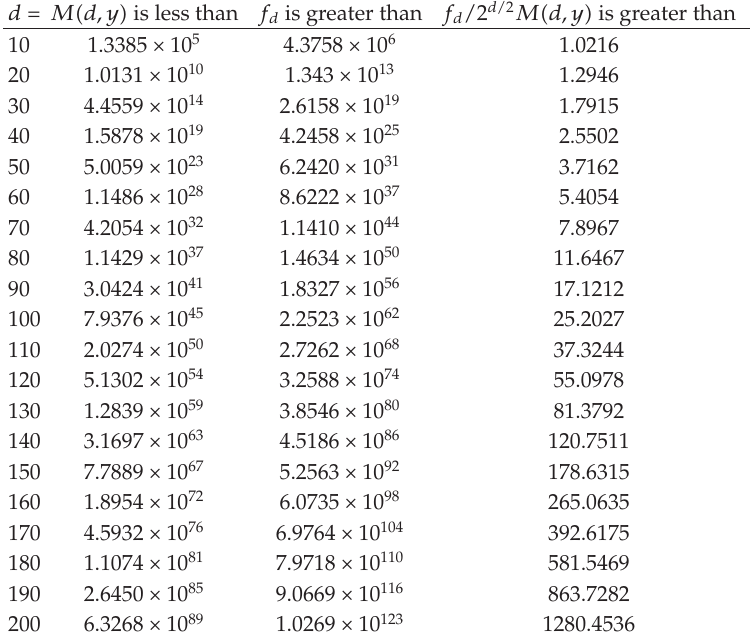
(cid:4) d 1 . 5 2 4 d/ 3 − 2 . d when y